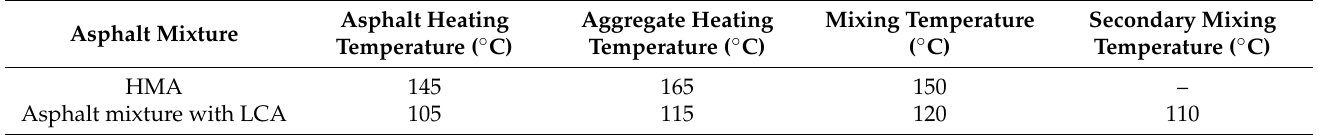
Table 7. Construction temperature of conventional HMA and LCAs-AM.